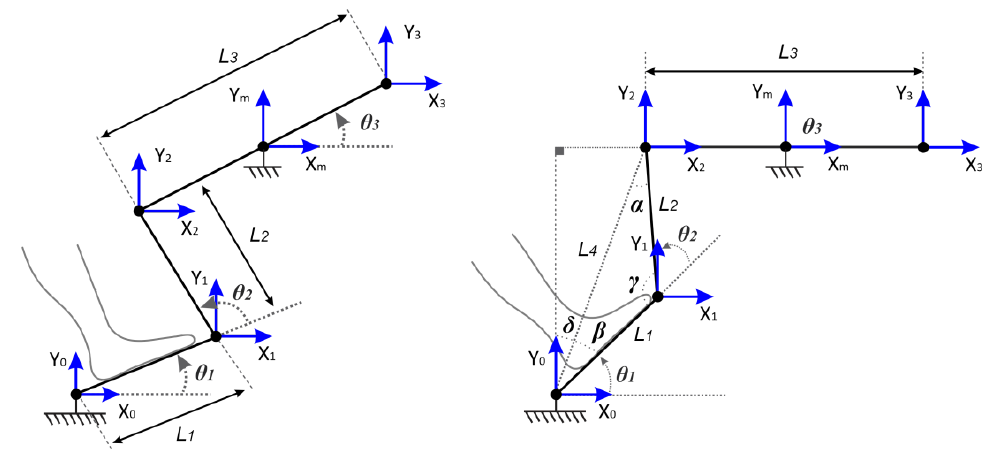
Figure 4. Kinematic model.